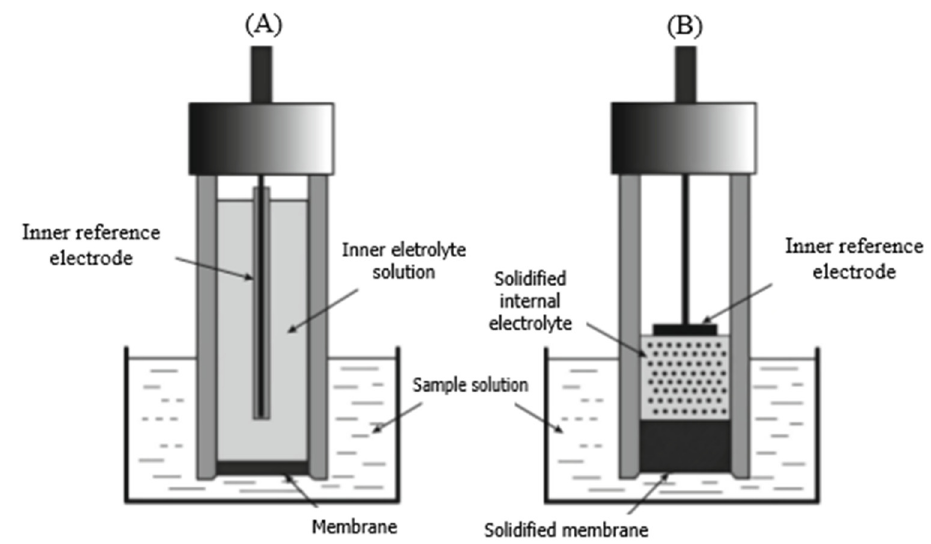
Figure 2. Diagram for the liquid contact ISE ( A ) and solid contact ISE ( B ).